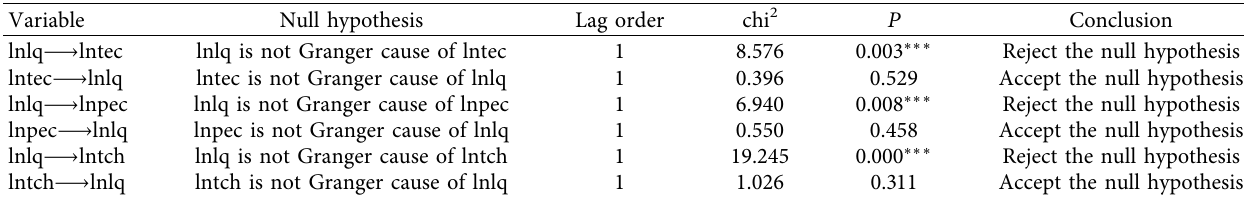
Table 5: Granger causality test results between variables.